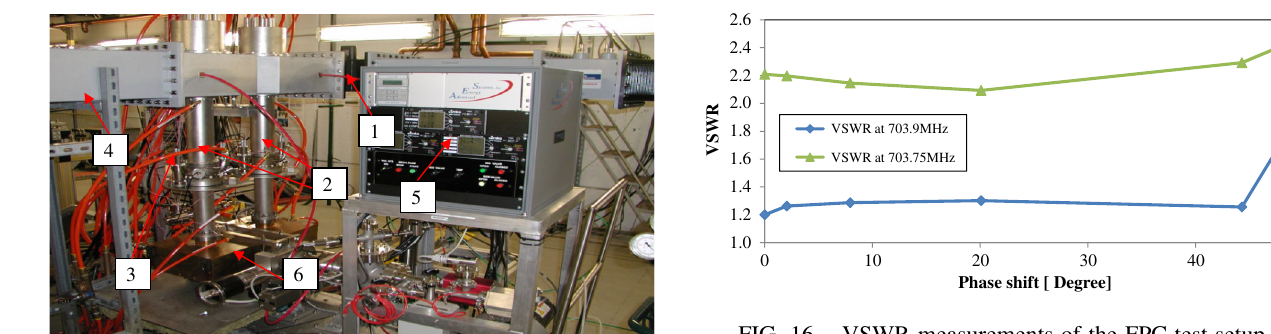
FIG. 16. VSWR measurements of the FPC test